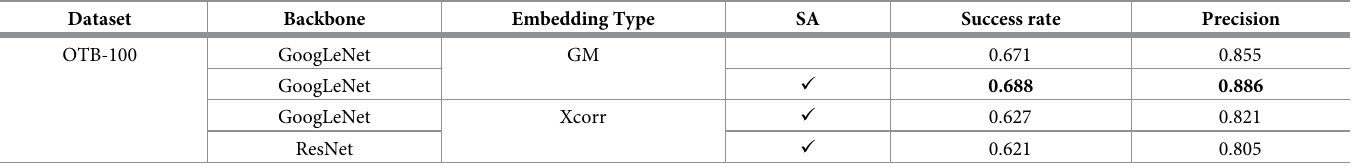
Table 1. Ablation experiments on OTB-100 benchmark. GM denotes graph matching, Xcorr denotes cross correlation, respectively, and SA means shuffle attention